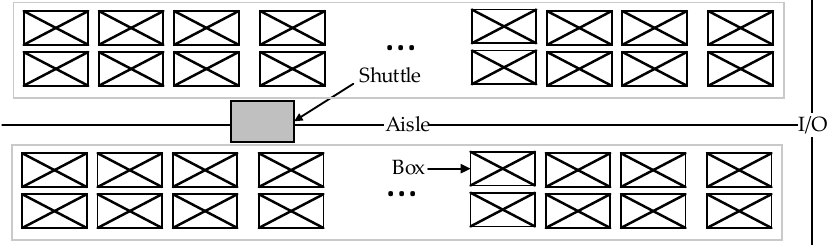
Figure 1. Double-deep outbound picking process.